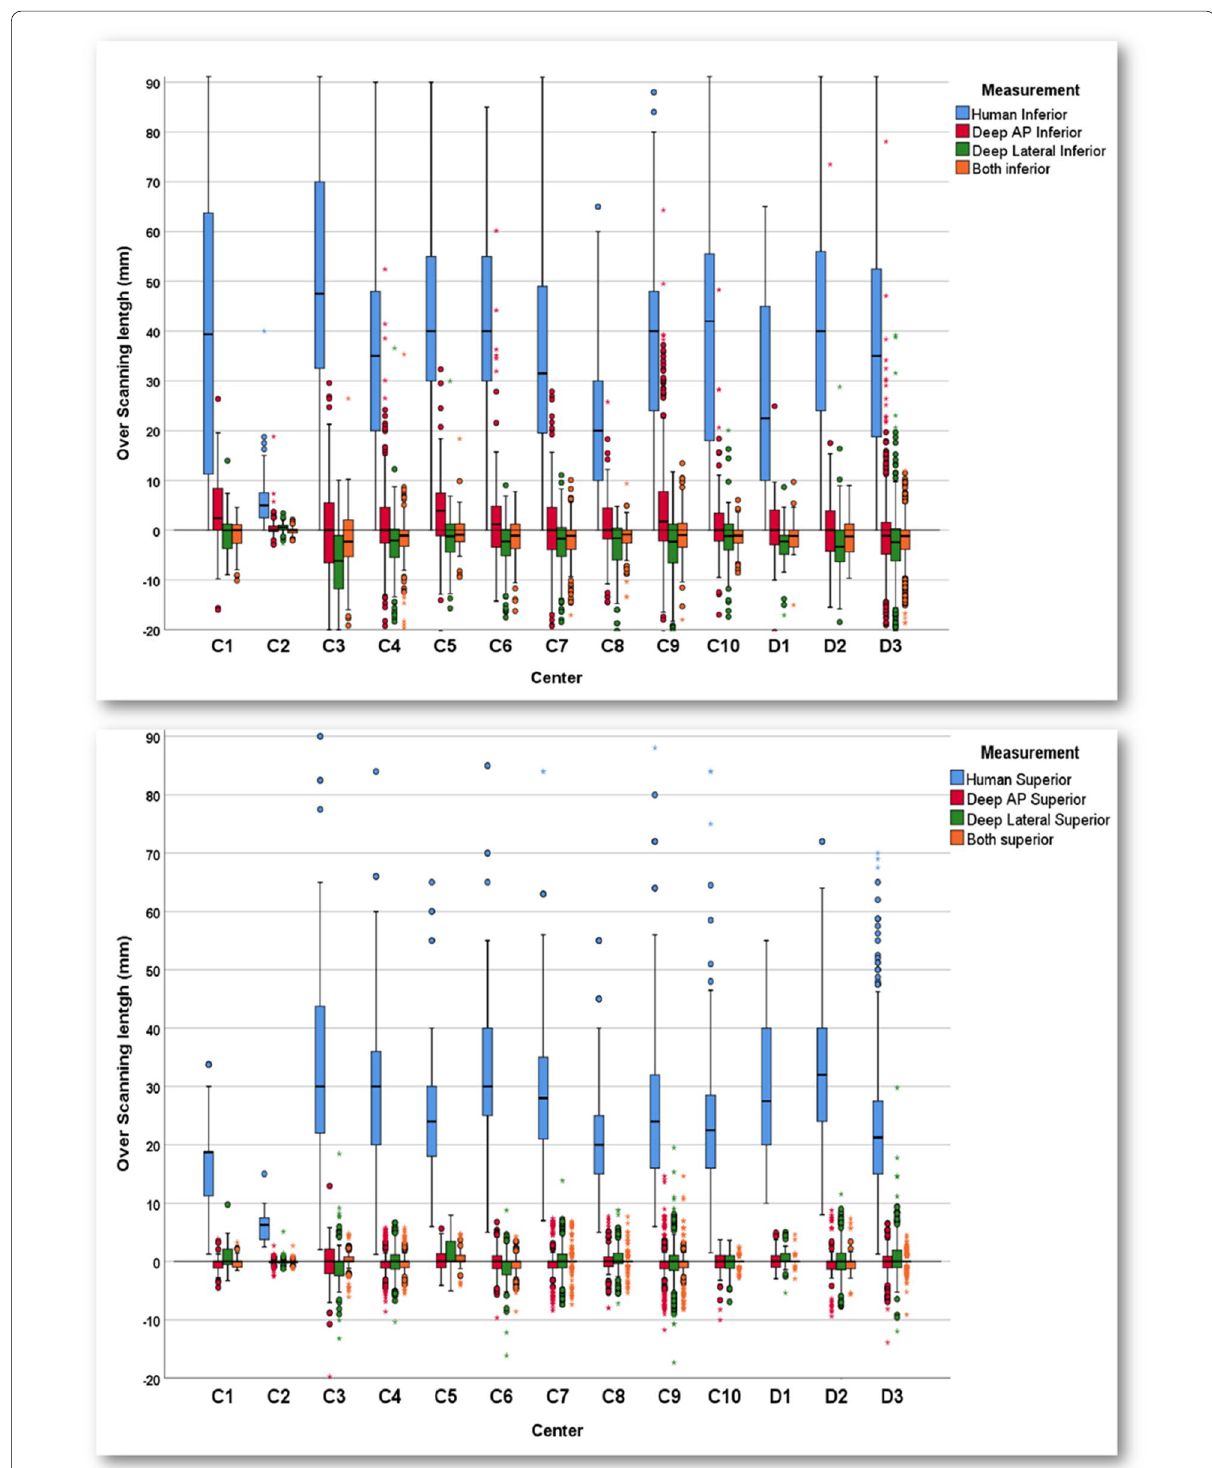
Fig. 4 Error from the desired exact lung coverage in the superior (bottom) and inferior (top) directions according to the technologist (Human) performance and DL approach based on AP, lateral, and both projections for different categories of